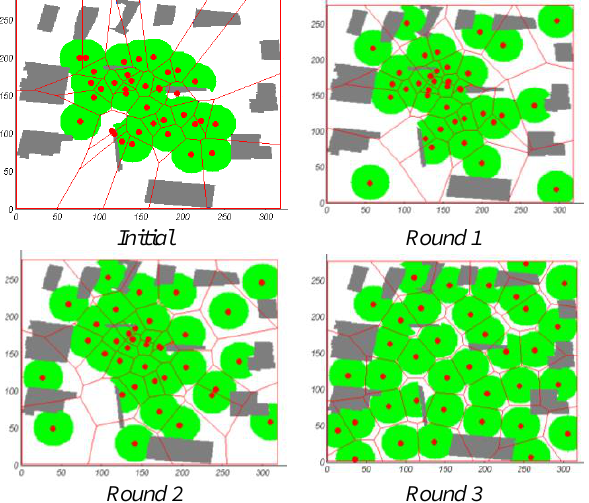
Figure 7. The results of applying the extended proposed VOR algorithm on a set of sample sensors